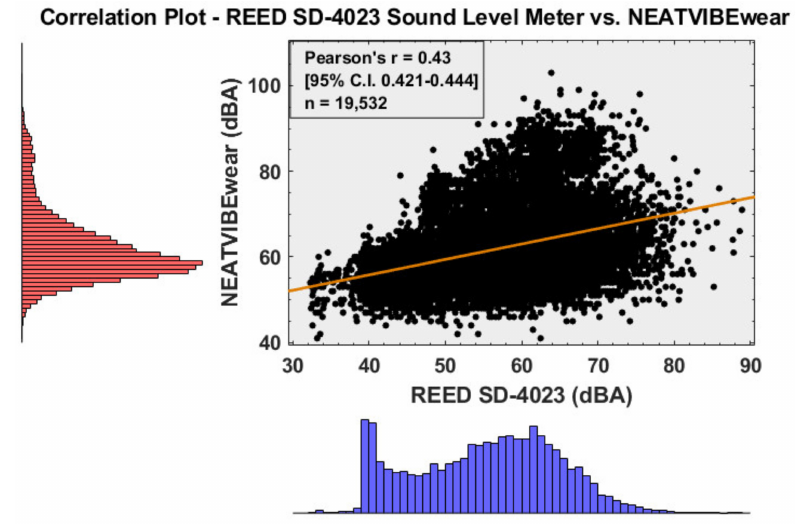
Figure 2. Correlation plot NEATVIBEwear vs. REED SD-4023 sound level